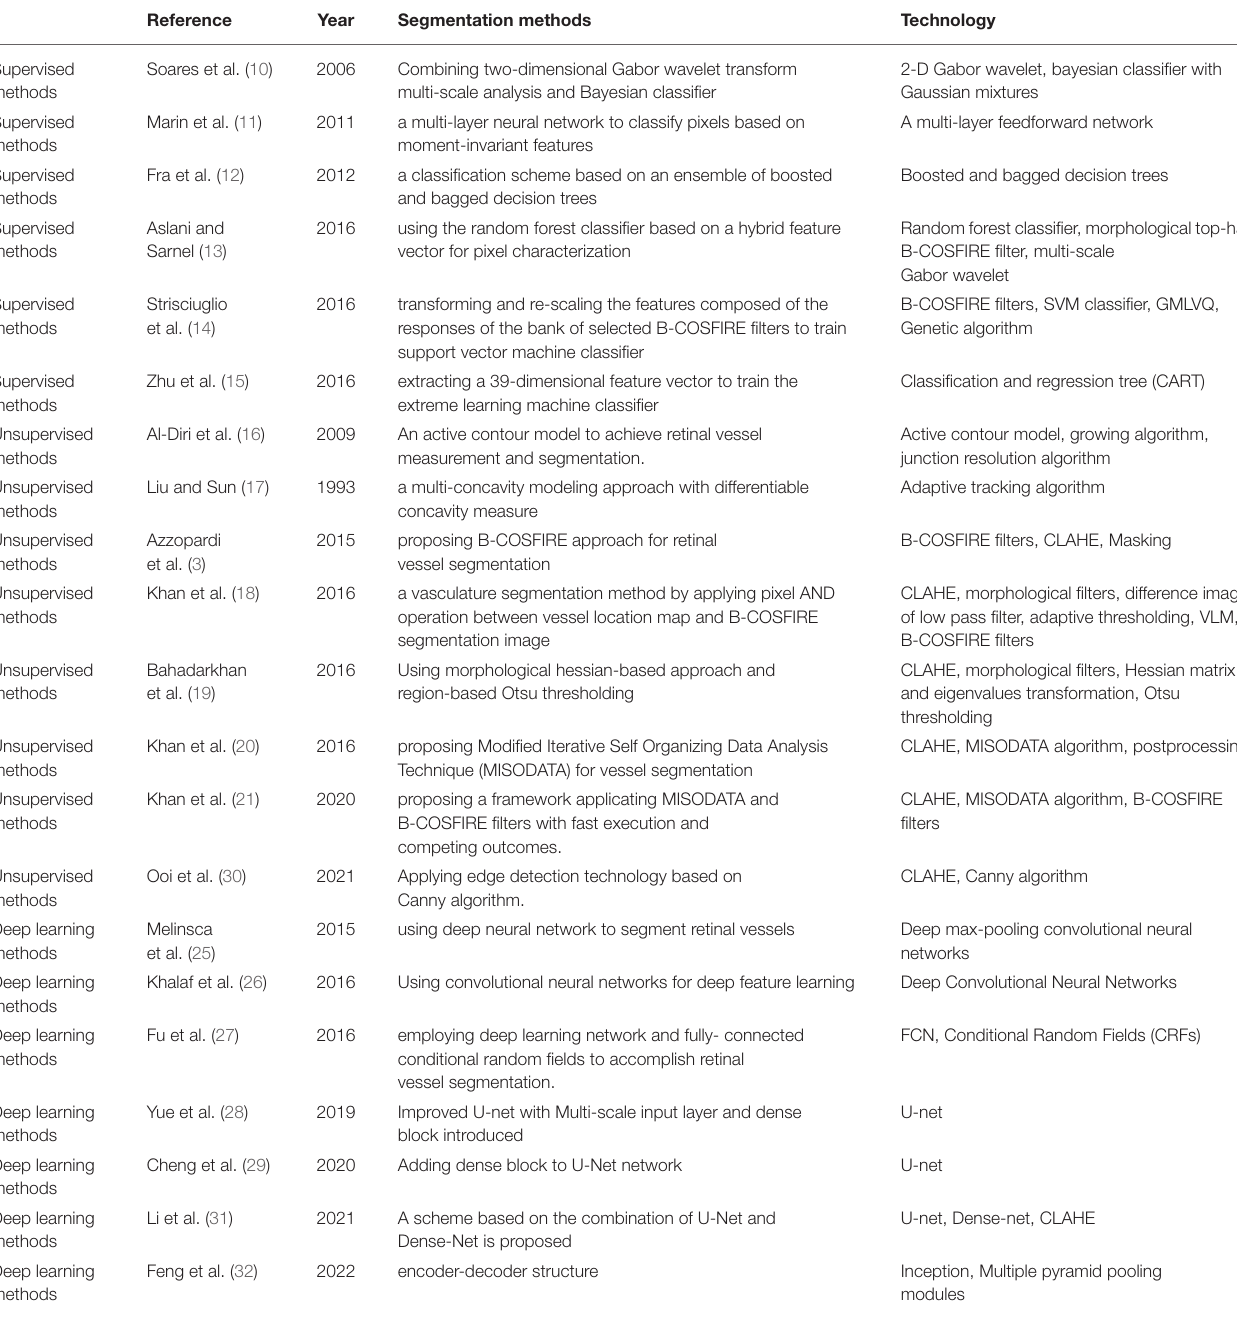
TABLE 1 | Related work of retinal segmentation